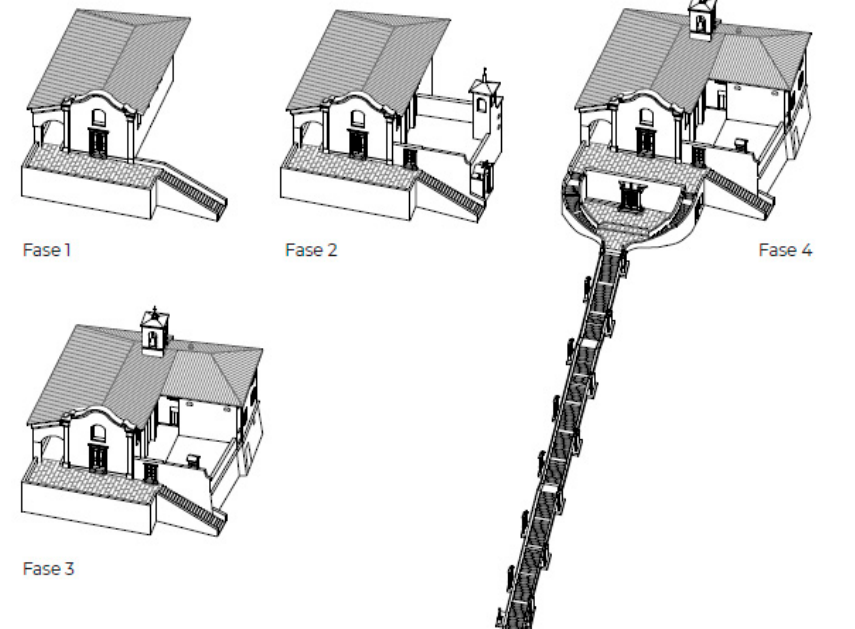
Figure 13. Diachronic development of the four phases of the sanctuary digital reconstruction model.